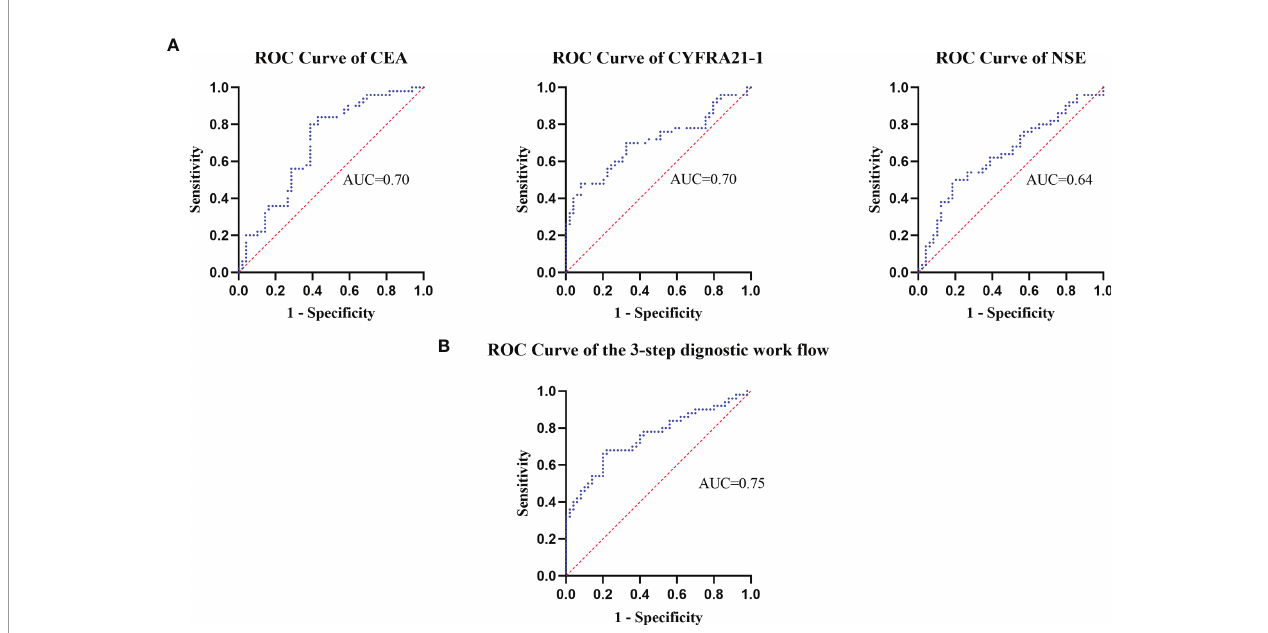
FIGURE 2 | The receiver operating curves were used to assess the dignostic value of plasma tumor marker's